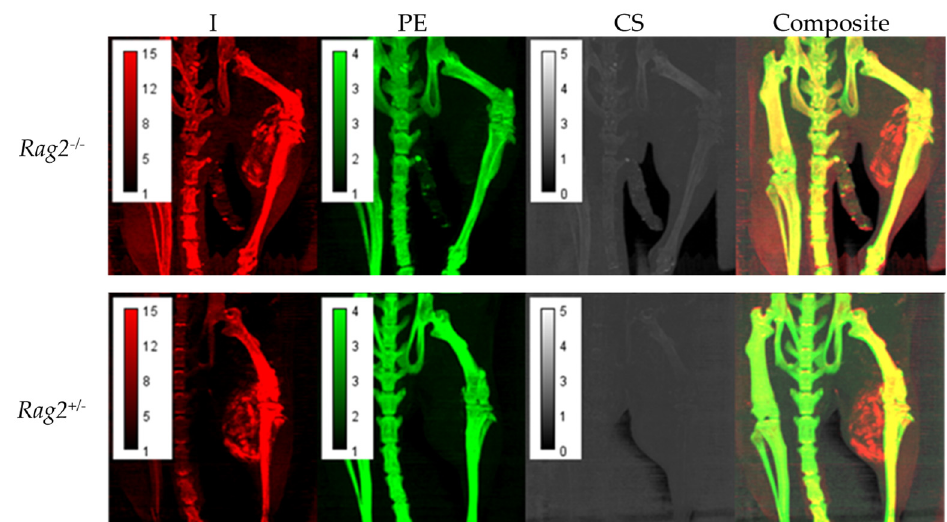
Figure 3. Maximum intensity projections (MIPs) of the decomposition maps for Rag2 − / − and Rag2 +/ − mouse demonstrating intratumoral nanoparticle accumulation and iodine enhancement as well as the overall quality of the decomposition results. Each pixel in these images represents the maximum voxel value across a projection through a given number of slices. In this case, we have chosen 20 coronal slices to capture the tumor vasculature.